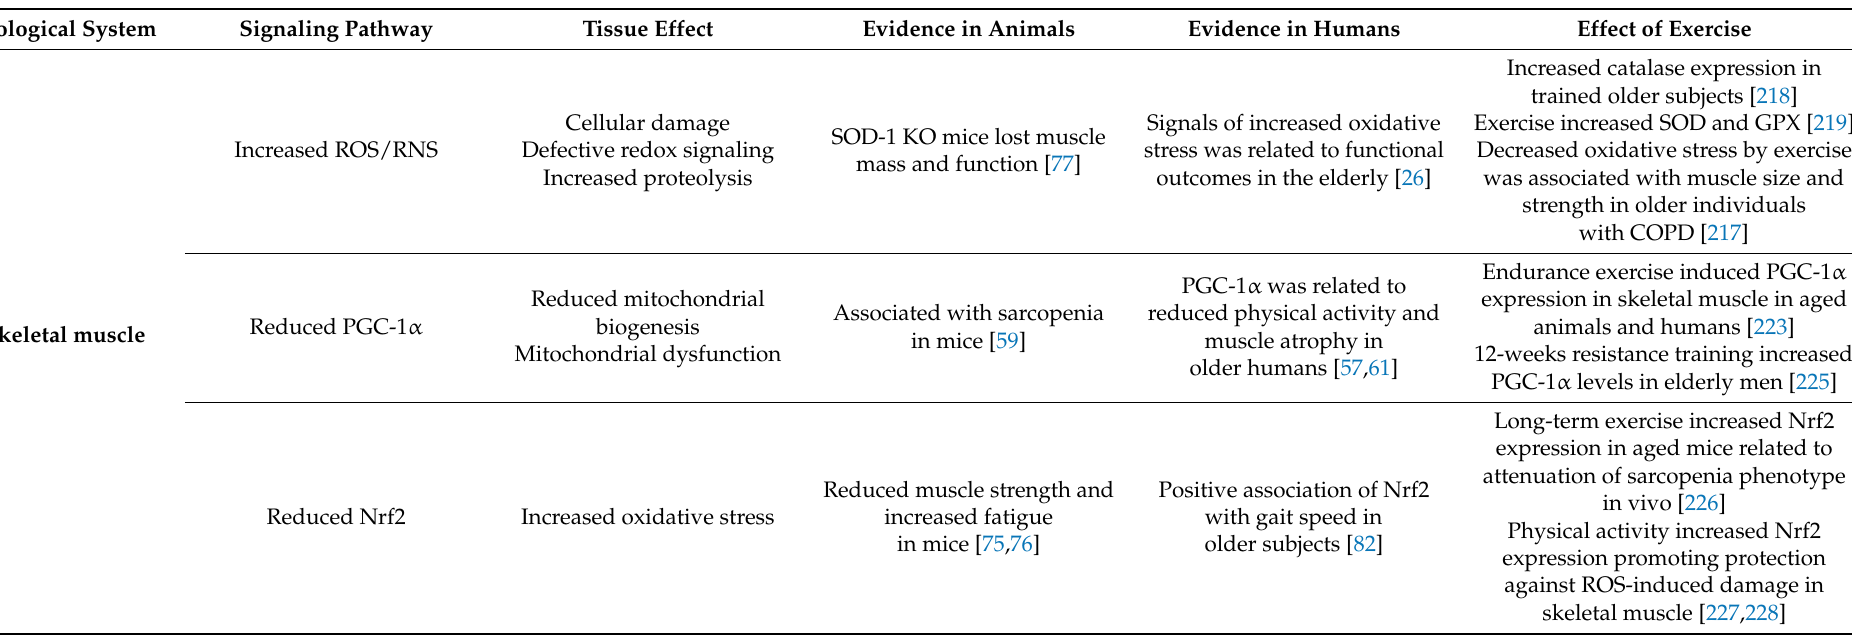
Table 1. Oxidative stress-related pathways influenced by aging and